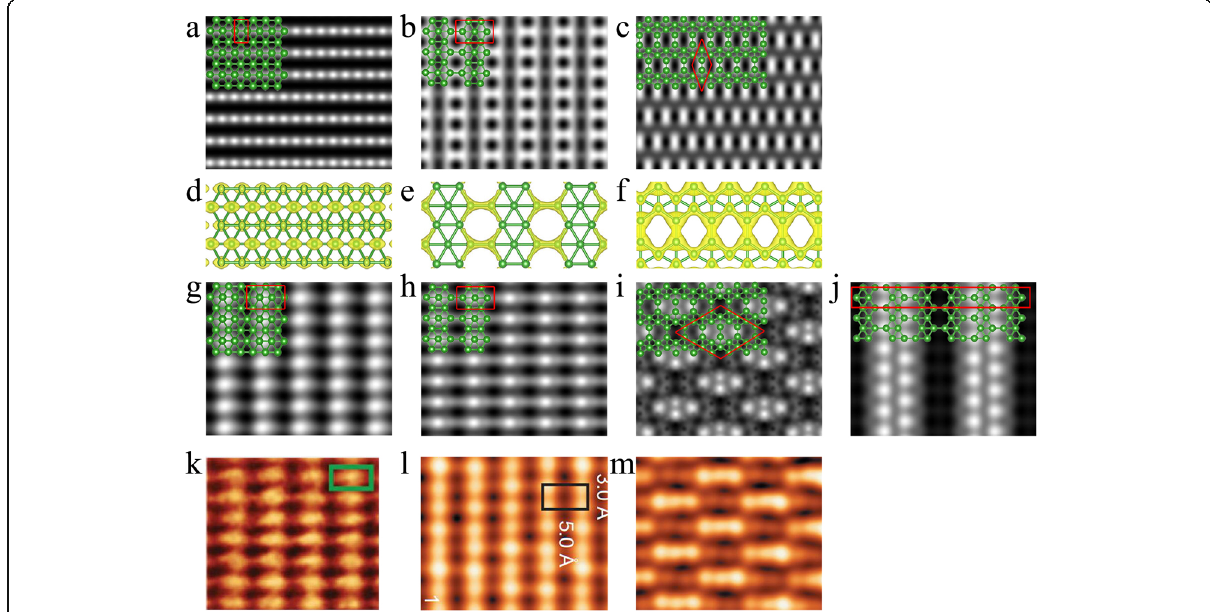
Fig. 5 Simulated STM images of freestanding and epitaxial boron sheets on Ag(111) surface. Freestanding a triangular, b β 12 , and c χ 3 boron sheets. Partial charge density of freestanding d triangular, e β 12 , and f χ 3 boron sheets. g Buckled triangular, h β 12 , i χ 3 , and j χ 3 ’ boron sheet on the Ag(111) surface. The bias voltage is 1.0 V. The green balls represent the boron atoms. The rectangles and rhombus enclosed by solid red lines denote the unit cells of freestanding and as-grown boron sheets on Ag(111) surface, respectively. Experimentally observed k stripe phase in Ref. [22], l stripe phase in Ref. [23], and m homogeneous phase in Ref.